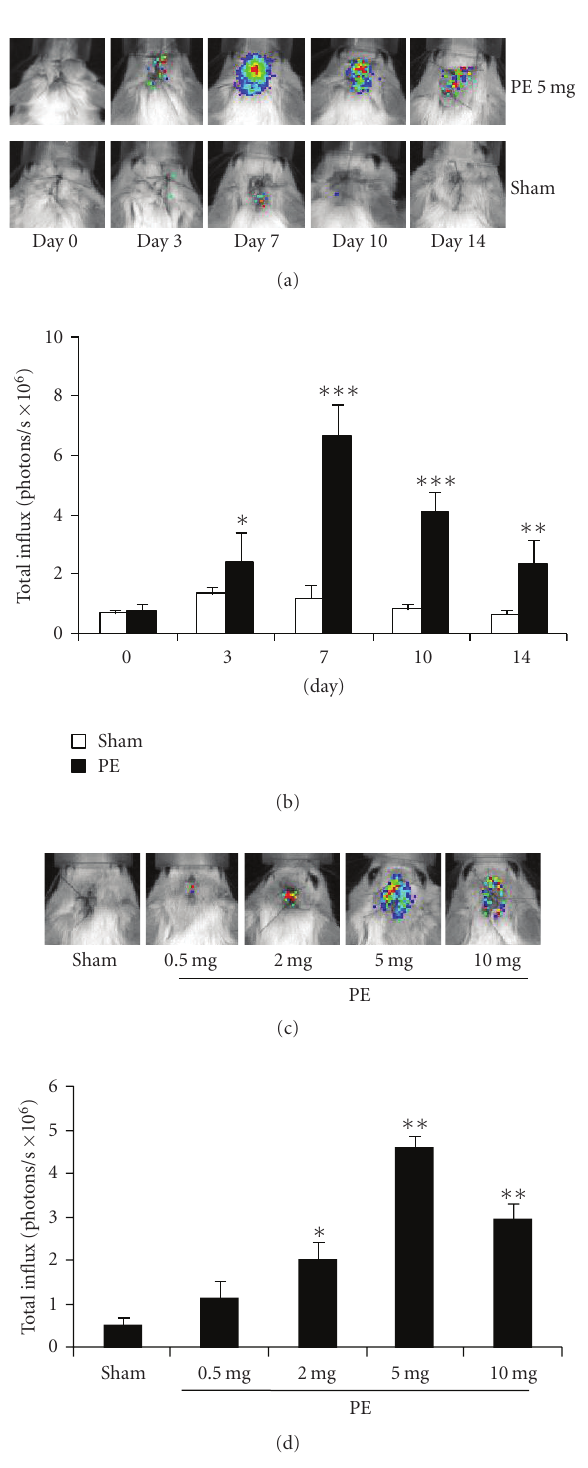
Figure 2: (a) In vivo imaging analysis was performed on the indicated days after loading of 5 mg PE. (b) Quantitative analysis of luminescence in (a) ( n = 3 per bar, Mean ± SD, ∗ P < . 05, ∗∗ P < . 001, ∗∗∗ P < . 0001, 5 mg PE versus sham at each time point). (c) In vivo imaging analysis performed on day 7 after loading of the indicated amounts of PE. (d) Quantitative analysis of luminescence in (c) ( n = 3 per bar, Mean ± SD, ∗ P = . 0005, ∗∗ P < . 0001 versus sham).